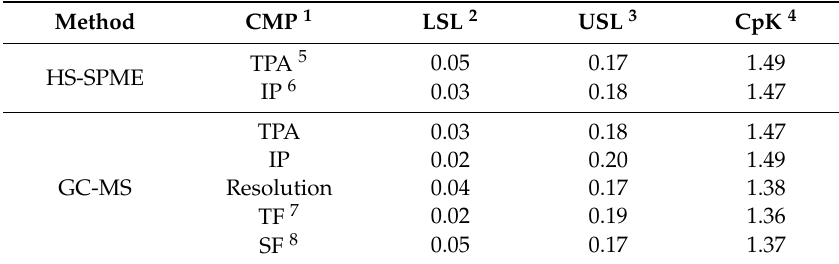
Table 2. Method control results.